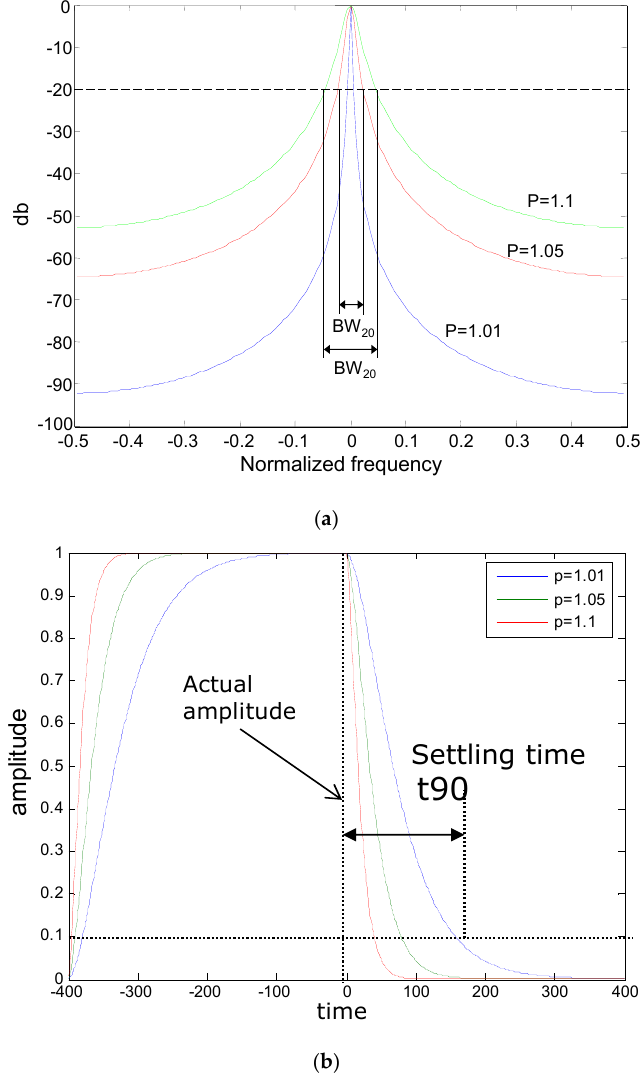
Figure 7. Performance of the IIR digital filter: Filter responses of the 0 Hz IIR digital filters with varied poles in ( a ) frequency and ( b ) time domains.